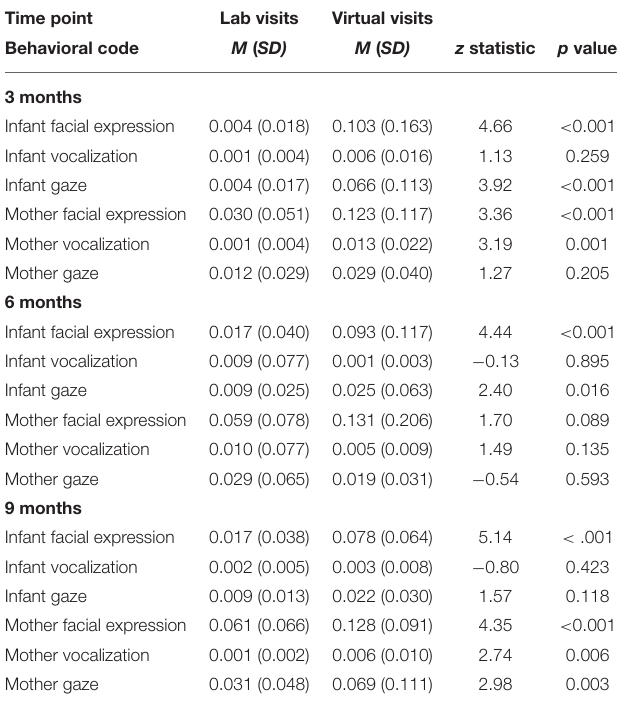
TABLE 4 | Proportion of missing data during the Still Face Paradigm by behavioral code, time point and visit